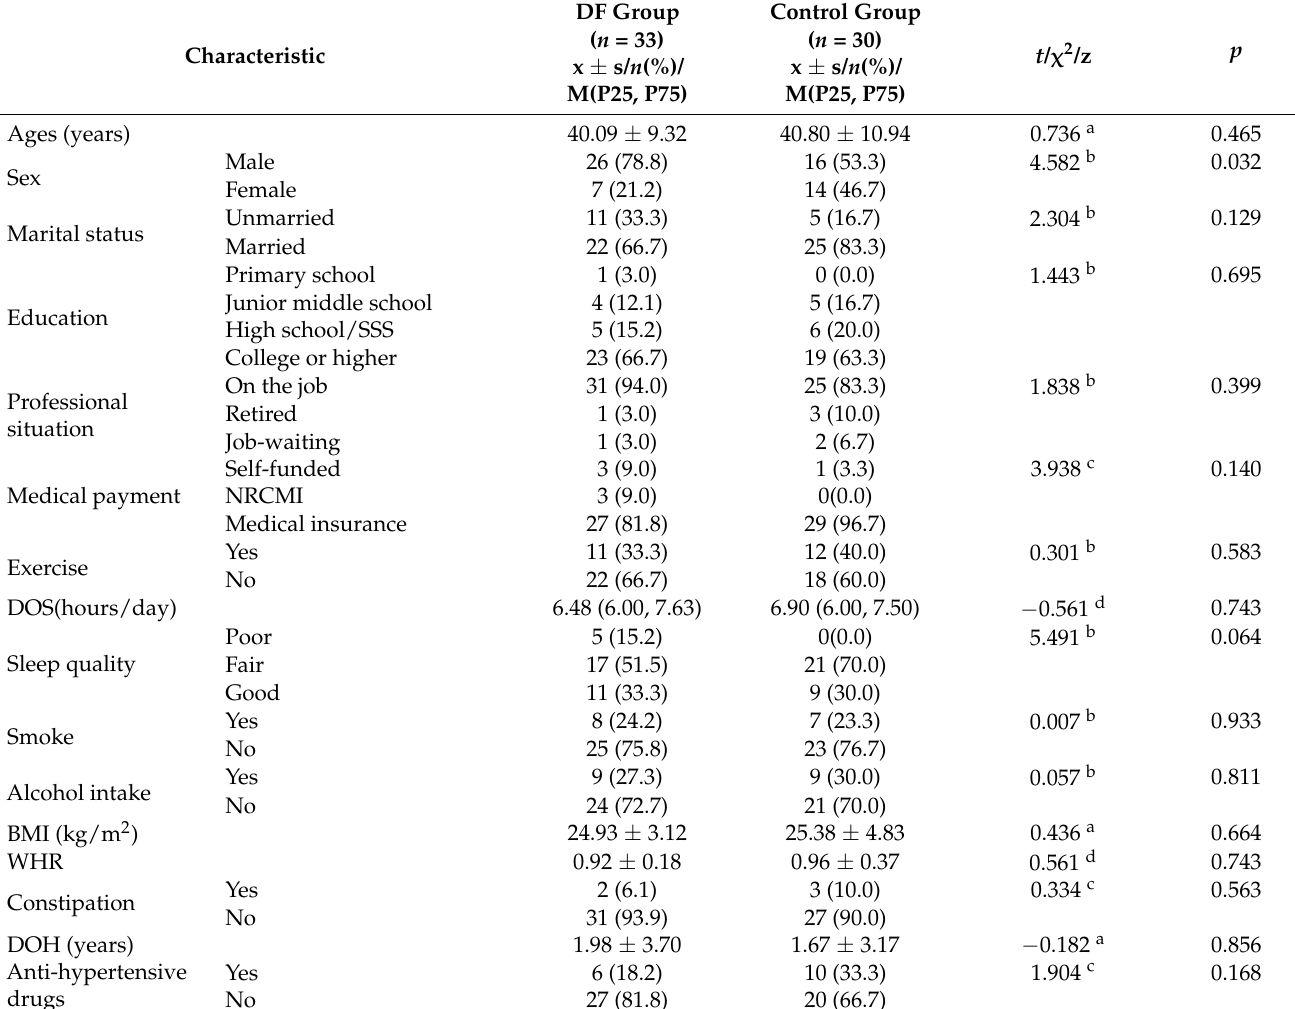
Table 1. Socio-demographic and clinical